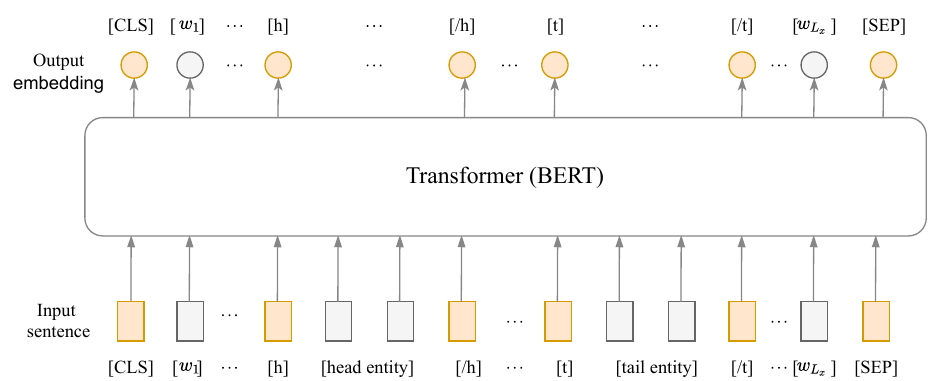
Figure 3. The feature encoder of our proposal. Orange items represent special mark tokens, e.g., [CLS] and [SEP] are the start and end of the input sentence with L x words, and [h] ([t]) and [/h] ([/t]) are the start and end of the head entity span and tail entity span,